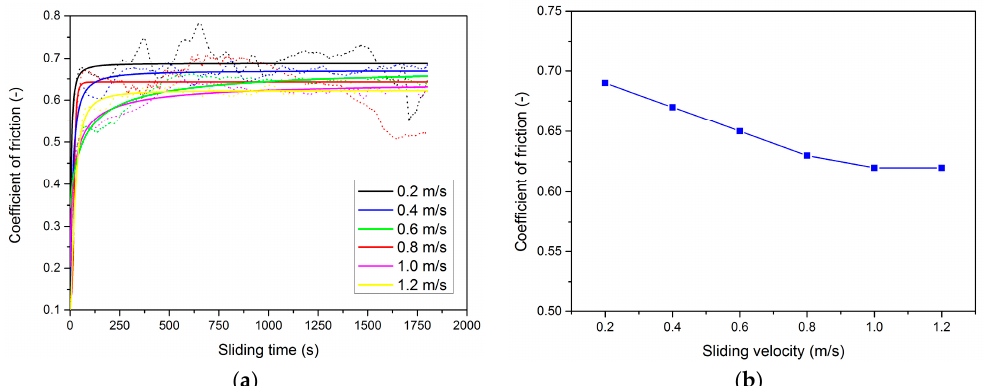
Figure 10. ( a ) Comparison of friction coefficients and their function override. ( b ) Average values of coefficients of friction.